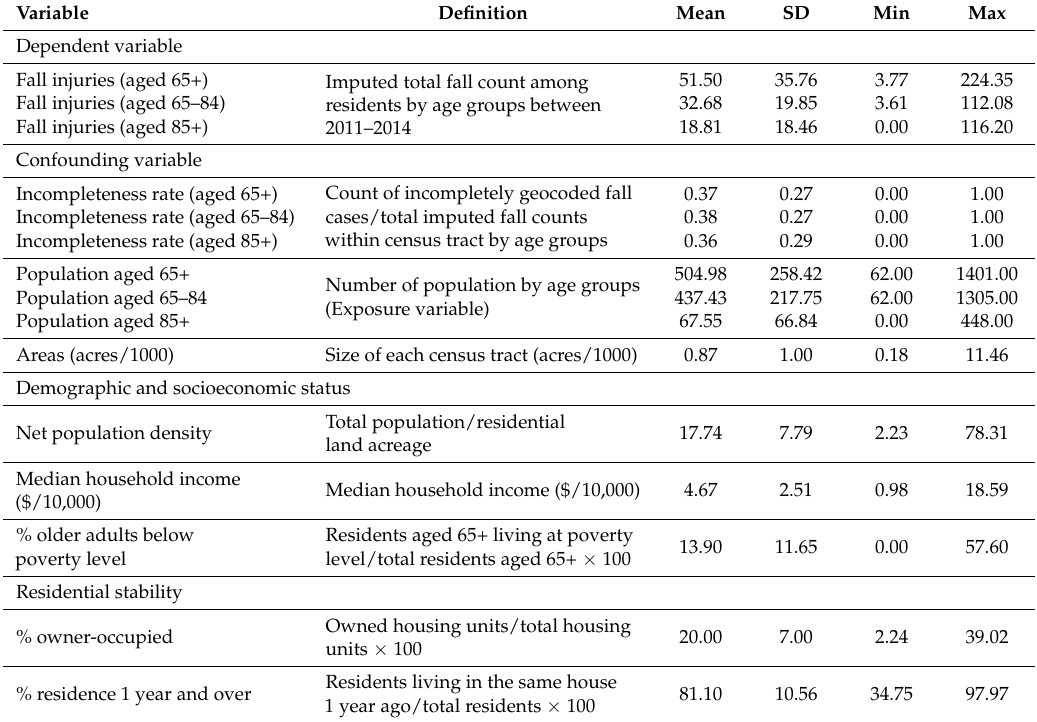
Table 2. Descriptive statistics of study variables for 264 census tracts in San Antonio,